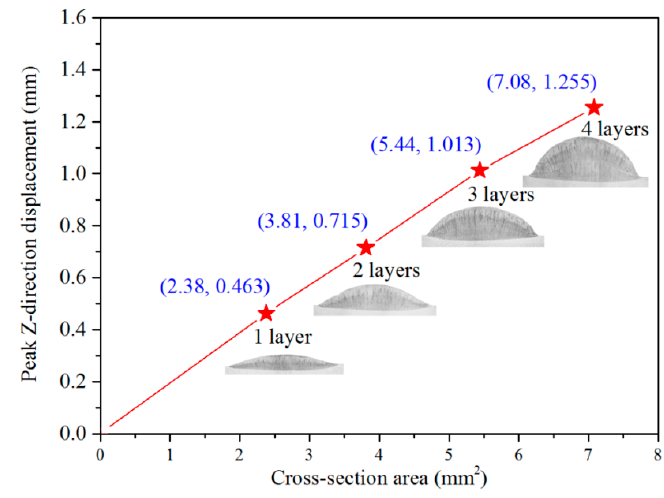
Figure 8. The evolution of distortion and its relationship with cross-section area.